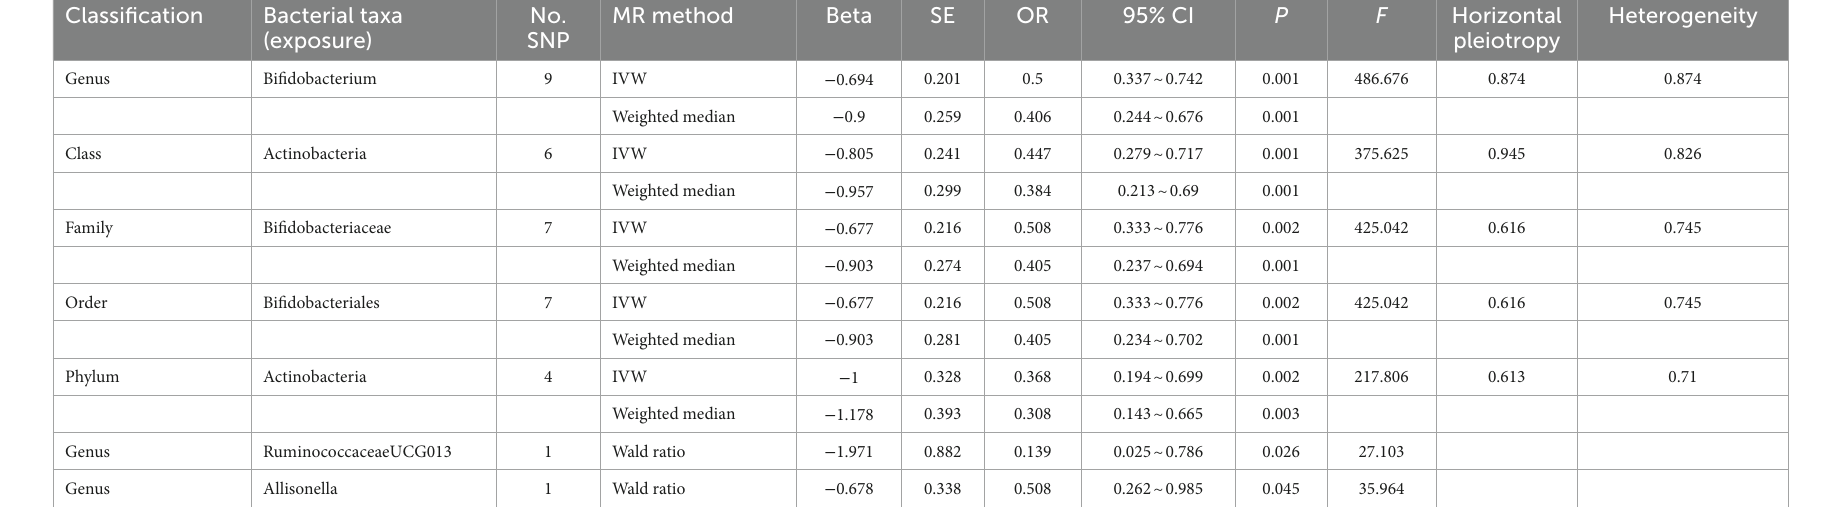
TABLE 4 Mendelian randomization analysis of gut microbiota on ADHD in replication samples (genome-wide statistical significance Level, p < 5 × 10 − 8 ).